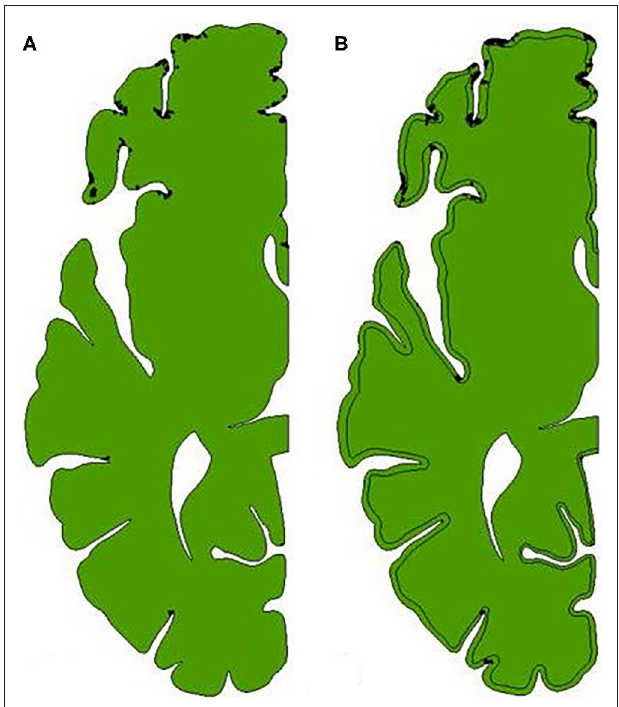
FIGURE 12 | Locations in the brain that experience a maximum shear strain > 0.25. Any element that is colored black has reached this threshold. The areas of the brains representing the subsequently lower bins (see Figure 11 ) tend to move out radially from the bases of the affected sulci. (A) Model with homogeneous brain. (B) Model with differentiated brain.